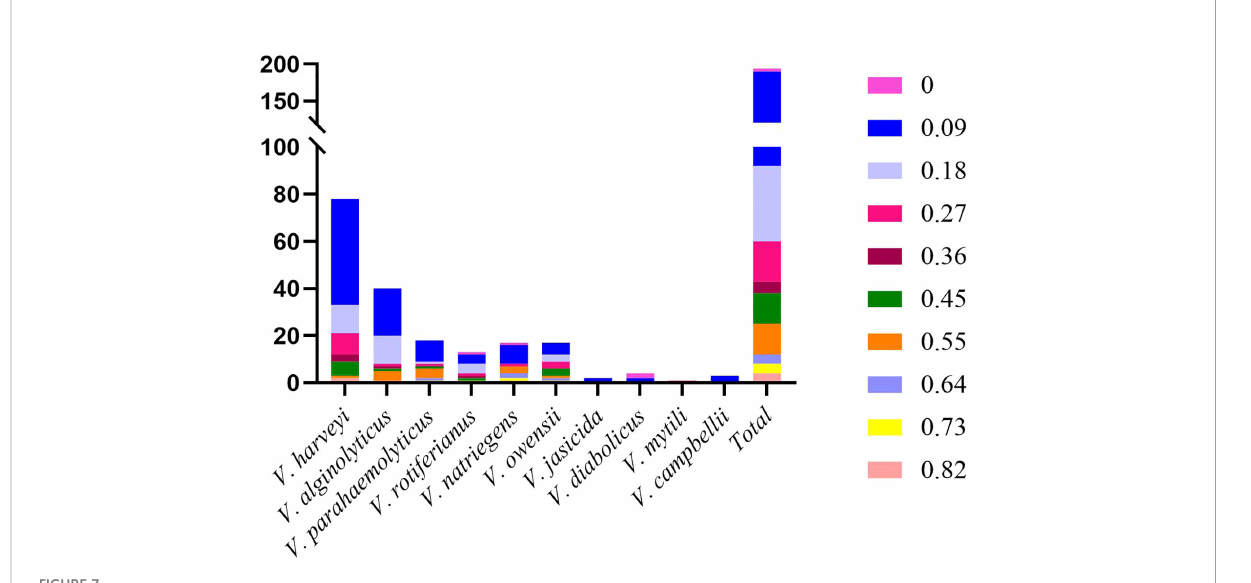
FIGURE 7 Distribution of multi-antibiotic resistance